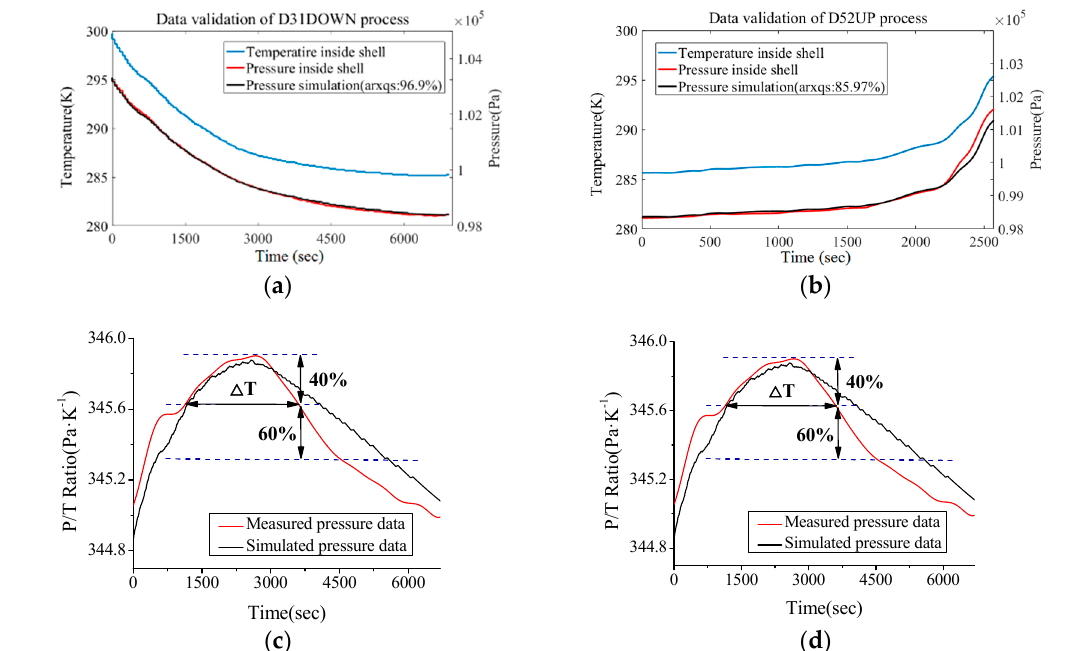
Figure 9. Data validation between real measurement group and predicted simulation group ( T c - P ). ( a ) Comparison for diving profile measurement process of #31 ROV task. ( b ) Comparison for floating profile measurement process of #52 ROV task. ( c ) Trend of P / T c during diving profile process of #31 ROV task. ( d ) Trend of P / T c during floating profile process of #52 ROV task.